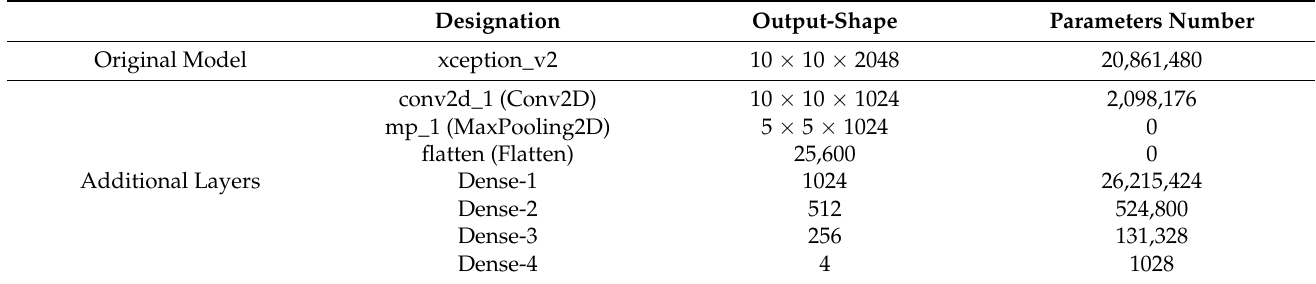
Table 4. The proposed modified based Xception model